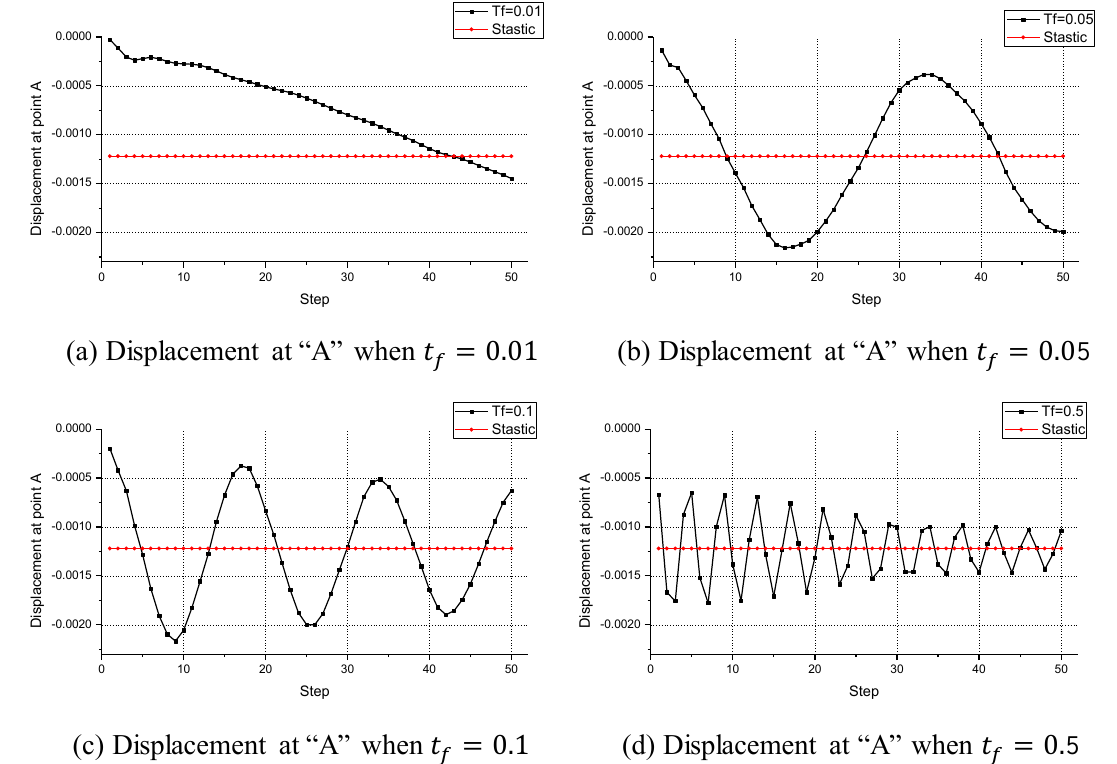
Figure 8. Displacement histories of the tip point for Michell − type structure.